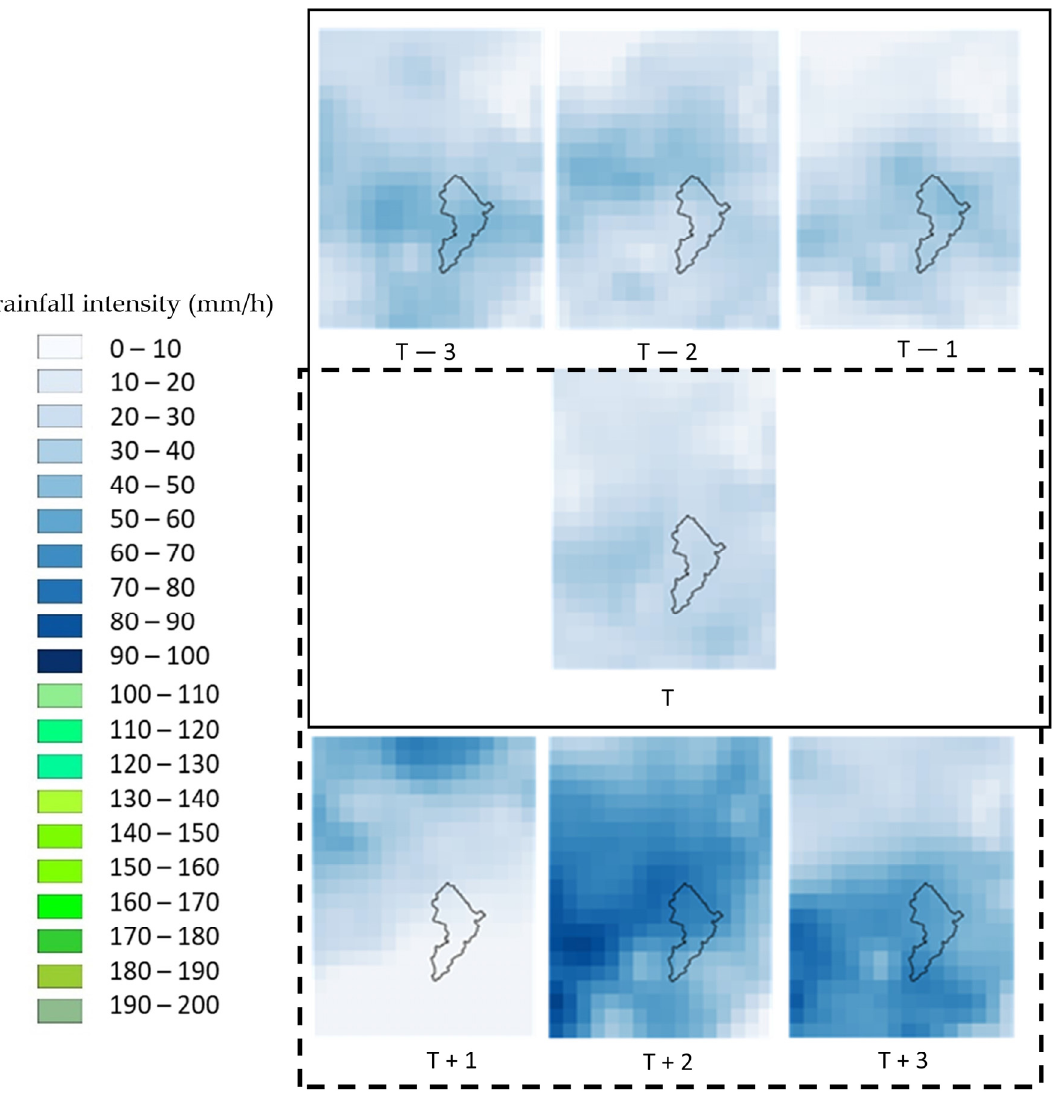
Figure 6. An example of current antecedent 3-h observed and next 3-h predicted color-classified rainfall intensity hyetographs over the study area.